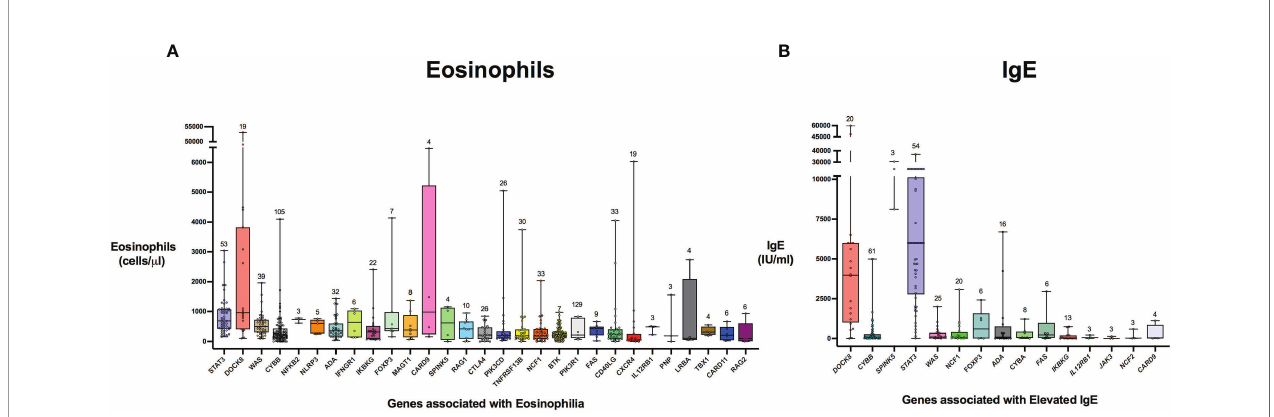
FIGURE 5 | Distribution of laboratory values in inborn errors of immunity associated with type 2 in fl ammation compared to the reference population. The genes are ordered by adjusted p-value from lowest to highest for eosinophil count (A) and IgE level (B) . For each gene, the box plot spans the interquartile range between the upper and lower quartile, with the median laboratoryvalue marked bythe black horizontal line across the colored box plot. The whiskers oneither sideof the box plot show the minimum andmaximum laboratory values. The value above each whisker indicates the number of patients for each IEI that were evaluated for eosinophiliaorIgE. HGNC gene symbols